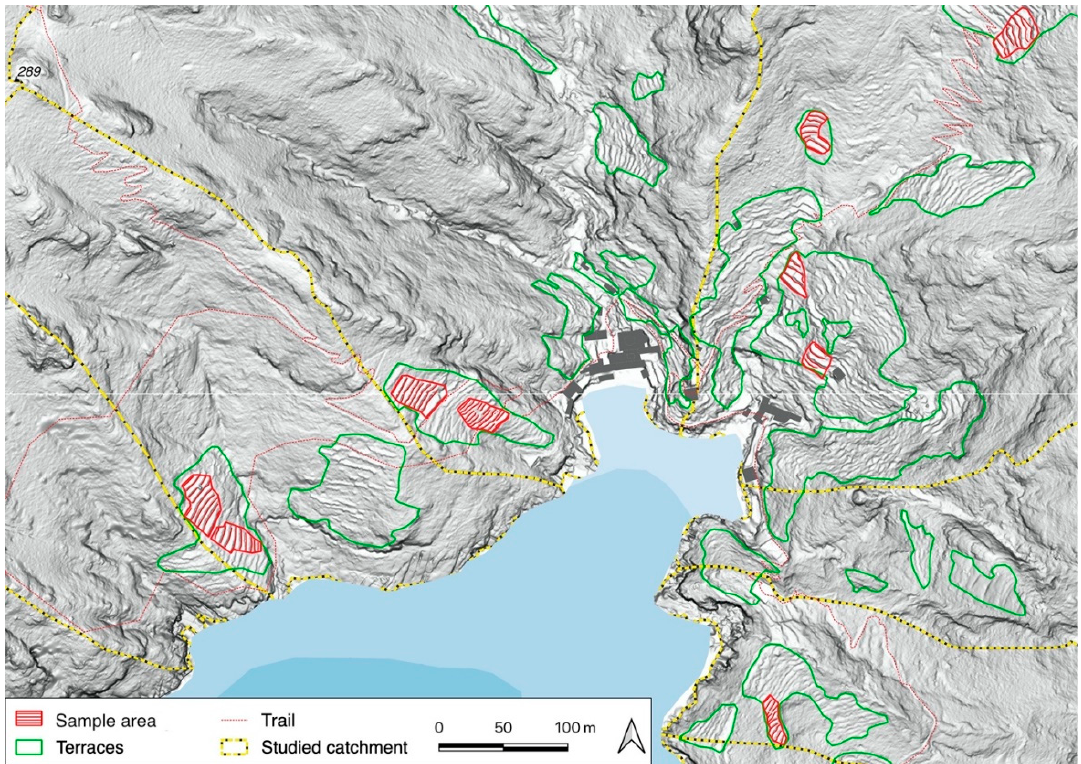
areas indicate the sample slopes used in the volume calculation.